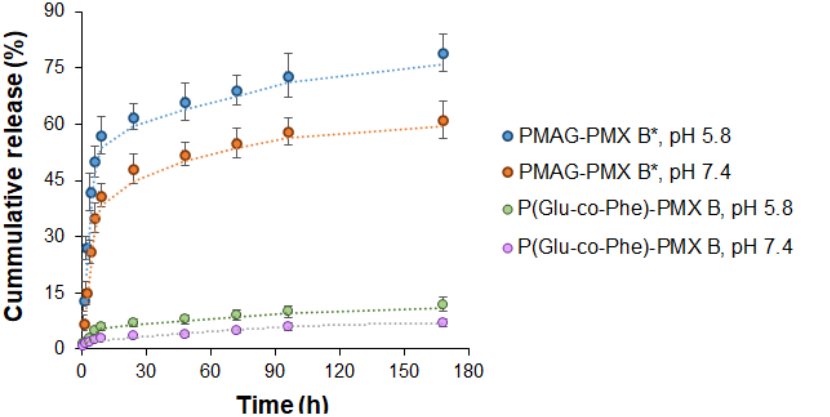
Figure 5. Release of PMX B from conjugates with PMAG (* in the form of Schiff base) and P(Glu-co-Phe) in 0.01 M sodium phosphate buffer with pH 7.4 or 5.8 at 37 ° C.